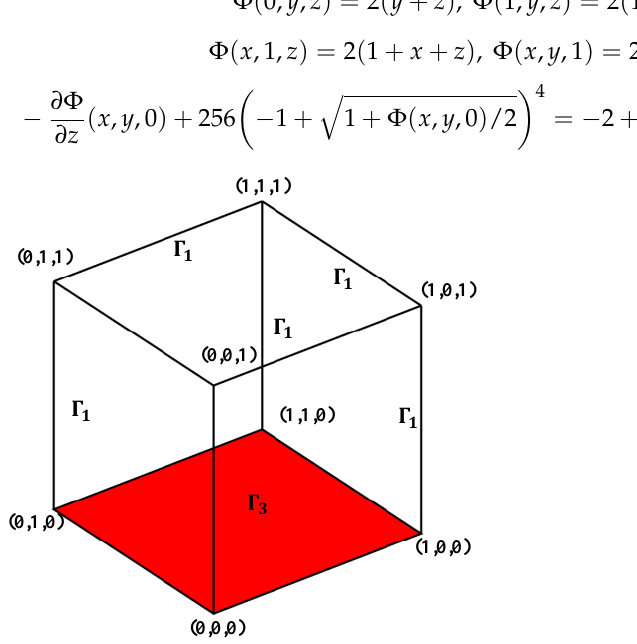
Figure 11. Schematic of the computational domain. In Figure 12, we test the influence of the number of local nodes when the total number of nodes is fixed at 3547. It can be seen that, when the total number of nodes is fixed, the maximum absolute decreases with the increase of the number of local nodes, the error of the LMFS solution is small when the number of local nodes is over 290.